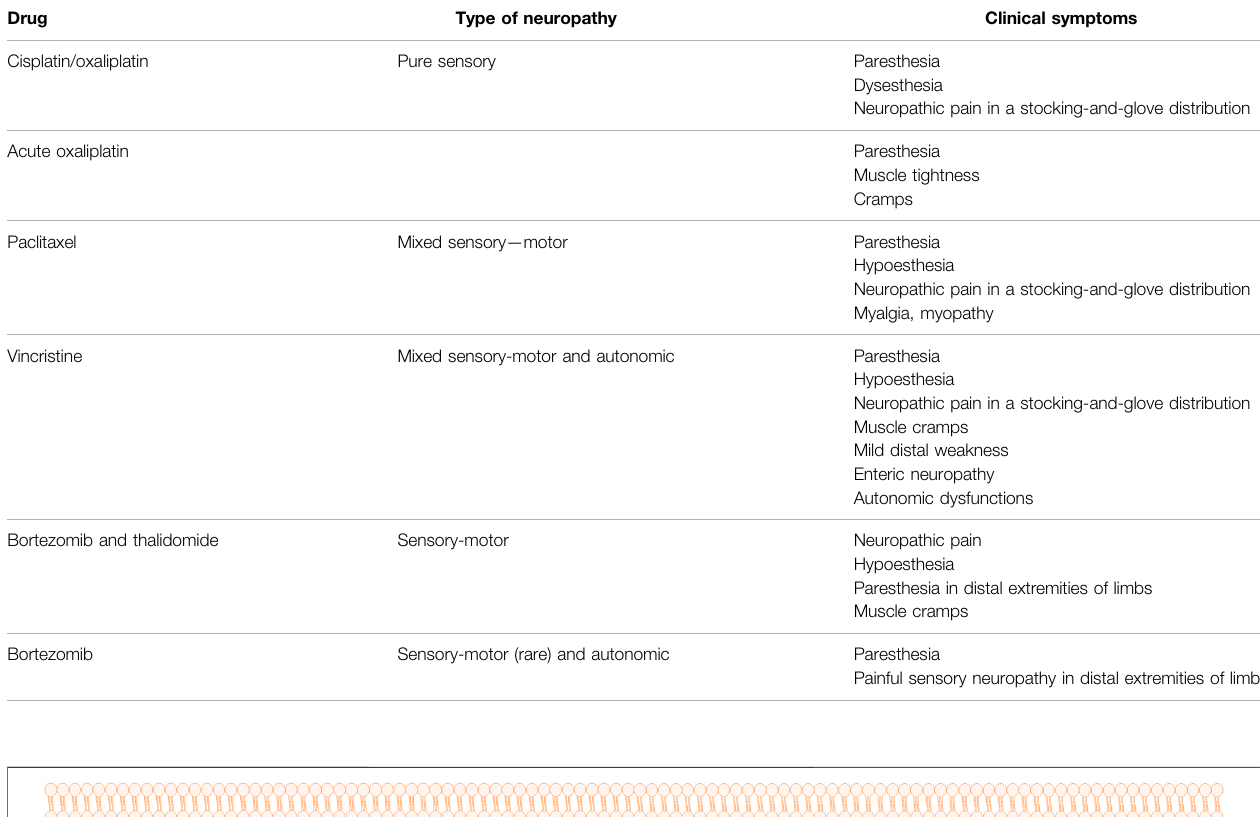
TABLE 2 | Chemotherapy induced neuropathy and clinical symptoms induced by representative antitumoral drugs.